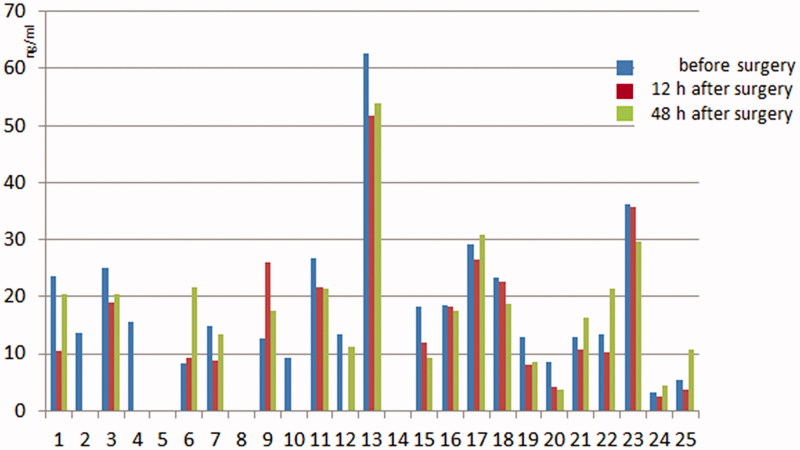
Serum CLU concentrations in patients.